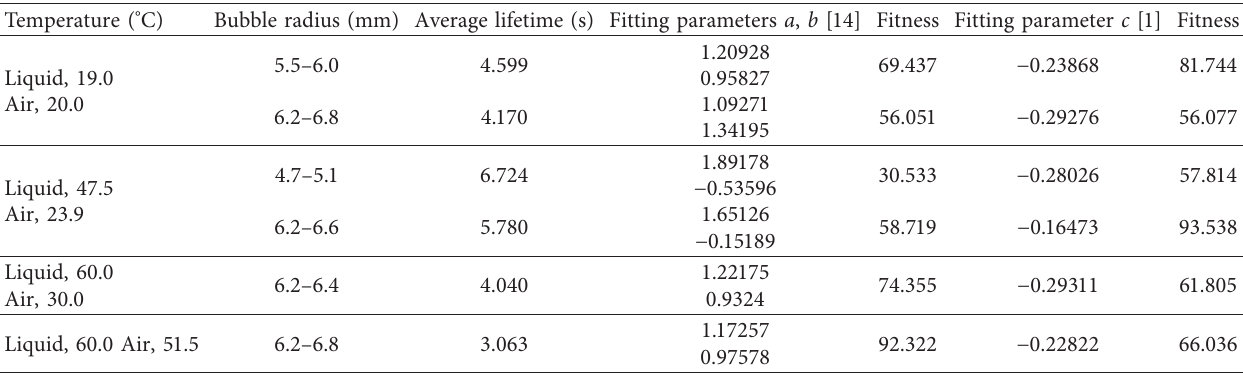
Table 1: Fitting results of bubble lifetime distribution on the surface of ionic water for different conditions. Temperature ( ° C)